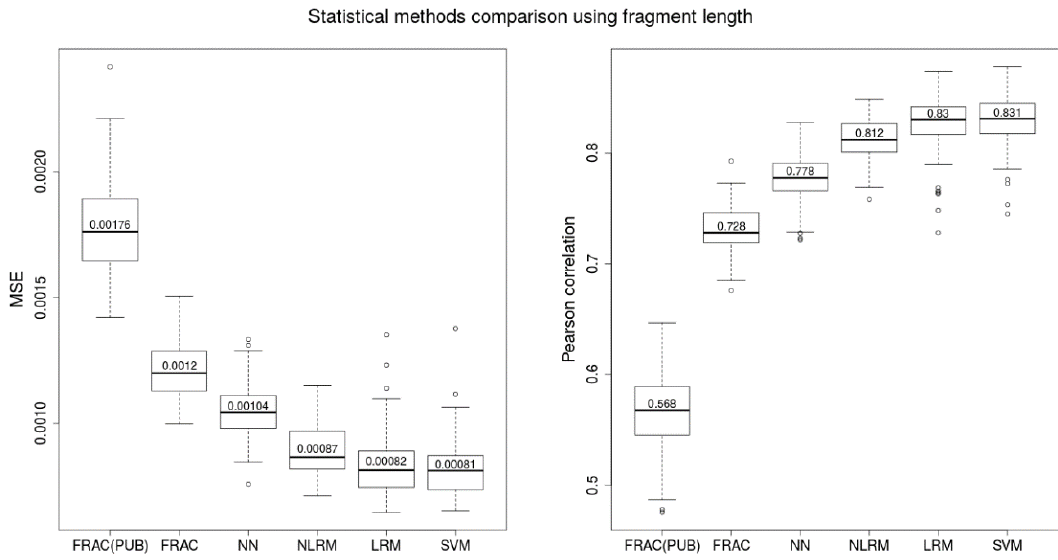
Figure 2. Boxplots of MSE and Pearson correlation of Y-based FF and estimated FF obtained from several di ff erent methods calculated for 100 testing sets. Training was performed on 100 complementary training sets. FRAC(PUB) represents the ratio of fragment length intervals designed by the study (Yu et al., 2014), FRAC means our best ratio of fragment length intervals derived by the best Pearson correlation with Y-based FF, NN—neural network, NLRM—non-linear regression model based on FRAC parameters, LRM—linear model using all fragment length parameters from 50–220 bp, SVM—support vector machine using all fragment length parameters from 50–220